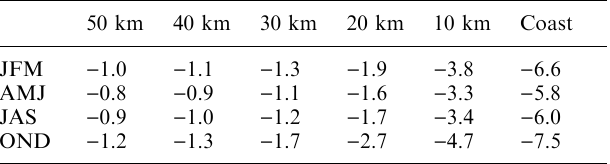
Table 2. Seasonal EW variations of the u-component of the horizontal wind (at the level of 990 hPa), at 15:00 LT, along line AB (Fig. 1). Units are m s ) 1